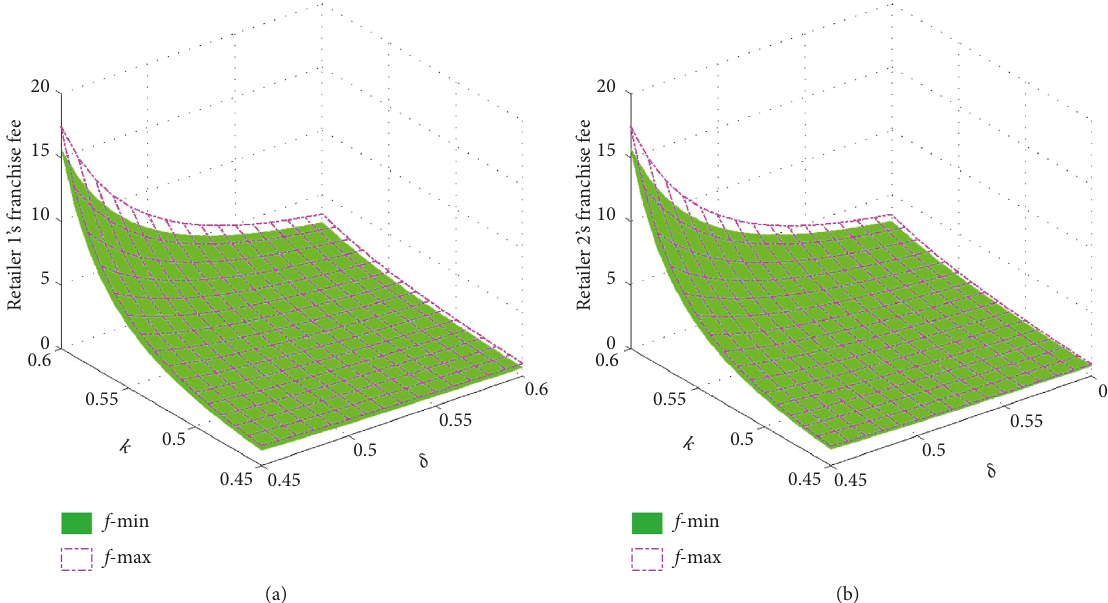
R M model. 1 2 0